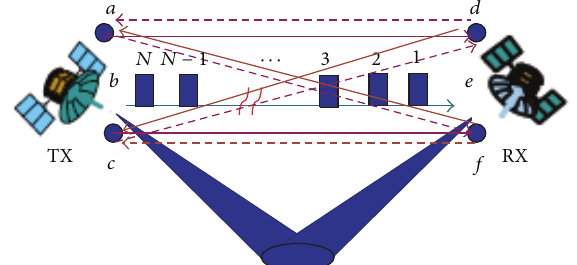
Figure 1: Two aerospace platforms and possible combination of navigation